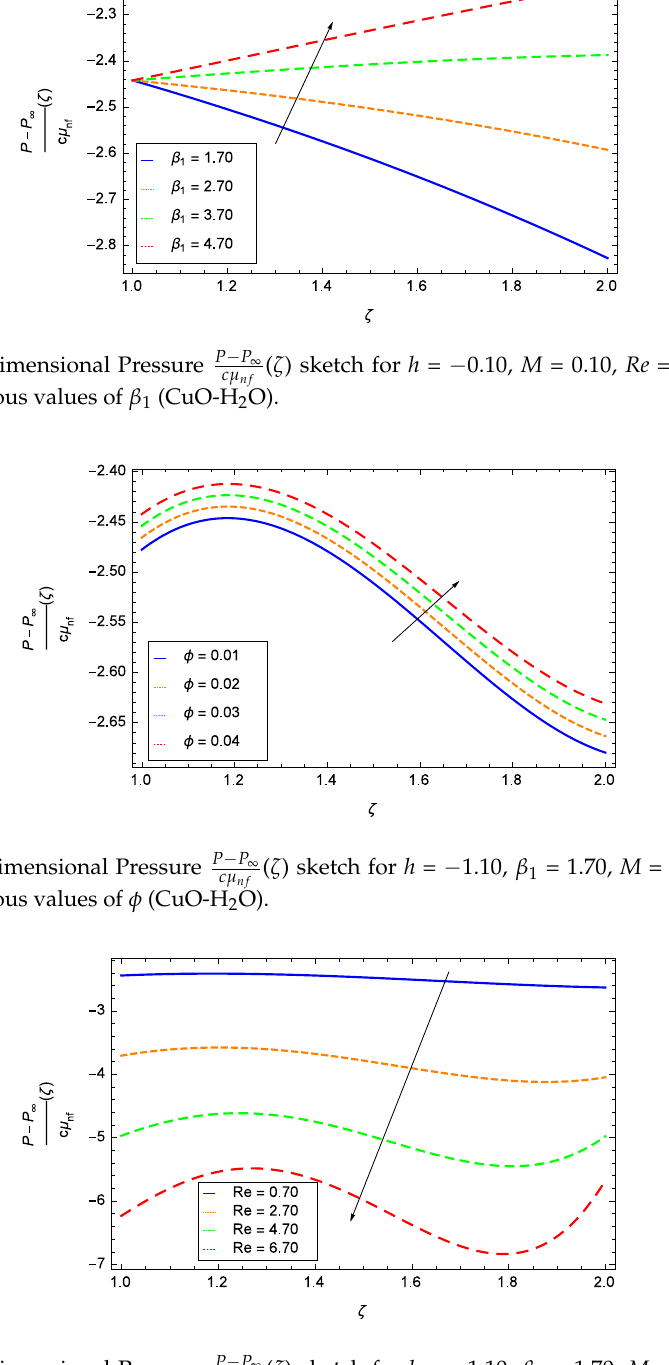
( ζ ) sketch for h = − 1.10, β 1 = 1.70, M = 0.10, φ = 0.04, c µ nf